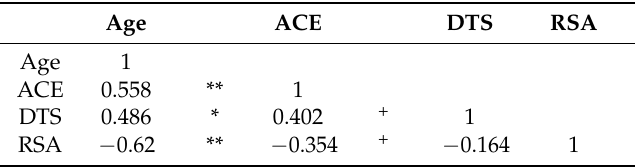
Table 2. The result of the correlation analysis of age, ACE, DTS, and RSA of the healthy group and the trauma group.